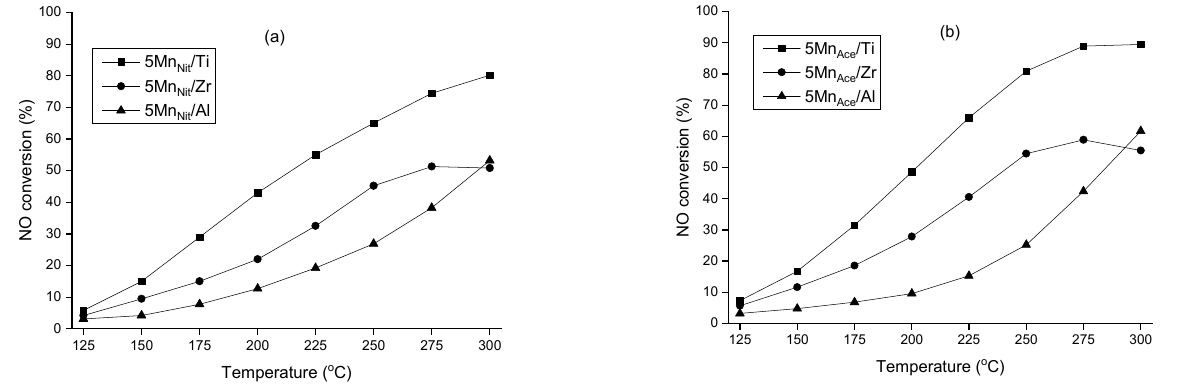
Figure 1. NO conversion profiles of: ( a ) 5Mn Nit and; ( b ) 5Mn Ace on various supports. Mn/TiO 2 doped with transition metals (e.g., Ni, Cu, and Fe) had high resistance to sintering and more favorable Mn dispersion [12]. It is also reported that Mn/TiO 2 cat- alysts promoted with transition metals showed activity for NO oxidation to NO 2